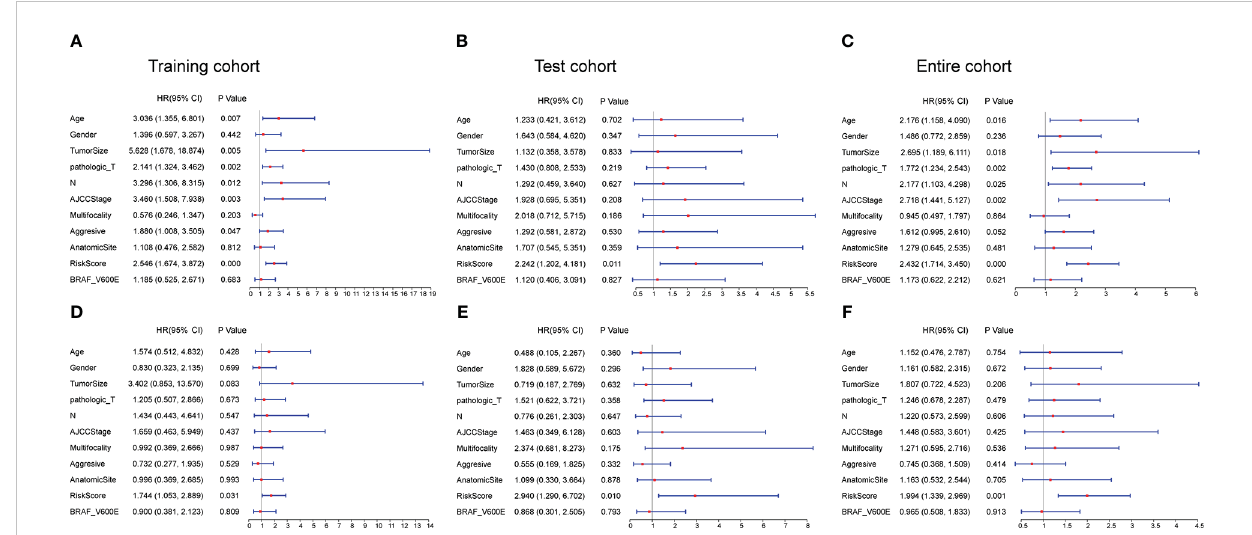
FIGURE 3 Univariate and multivariate Cox regression analyses of the signature and clinical characteristics. (A – C) Univariate Cox regression analysis of the signature risk score and clinical characteristics in the training, test, and entire cohort. (D – F) Multivariate Cox regression analysis of the signature risk score and clinical characteristics in the training, test, and entire